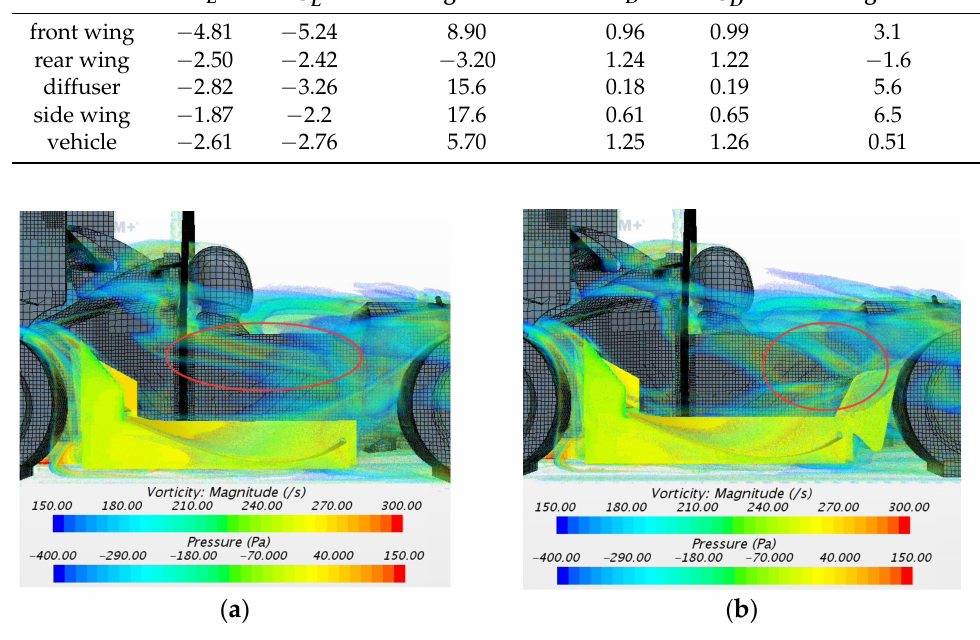
Figure 20. Comparison of vorticity above the side wing. ( a ) Original condition, a jet of strong vortex is generated; ( b ) the strong jet is cut into two weaker parts after implementing the shutters.